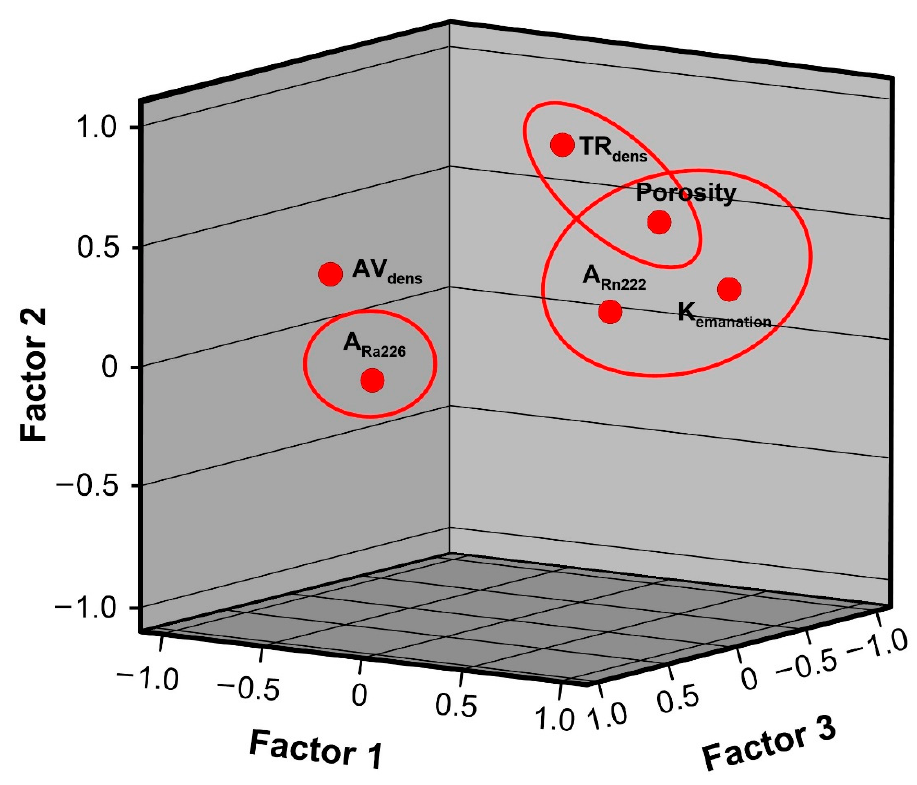
Figure 6. Plot of factor loadings for studied parameters of radon emanation.